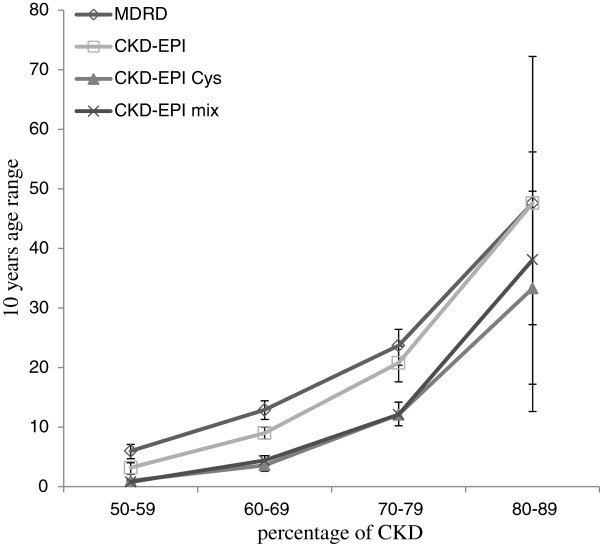
Prevalence (in % with the 95% confidence interval) of CKD according to age (X axis: 10 years age range) (Y axis: percentage).